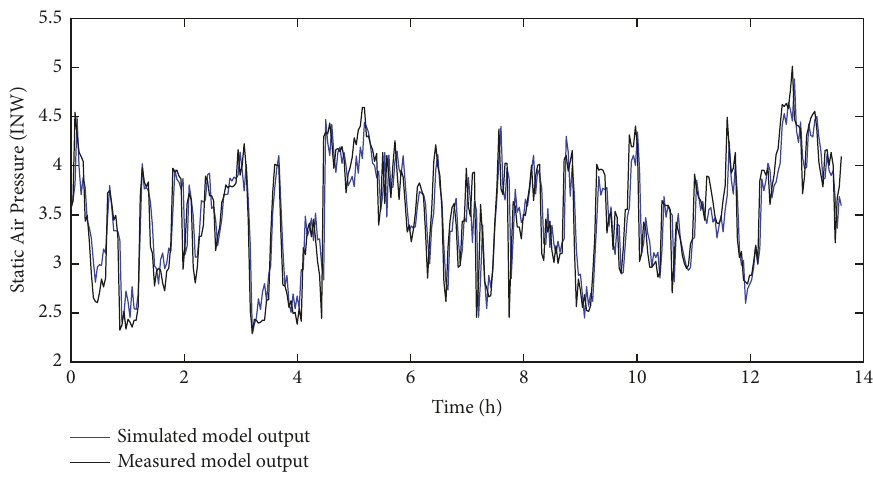
Figure 26: Validation of real measurements and outputs of the static air pressure model fit